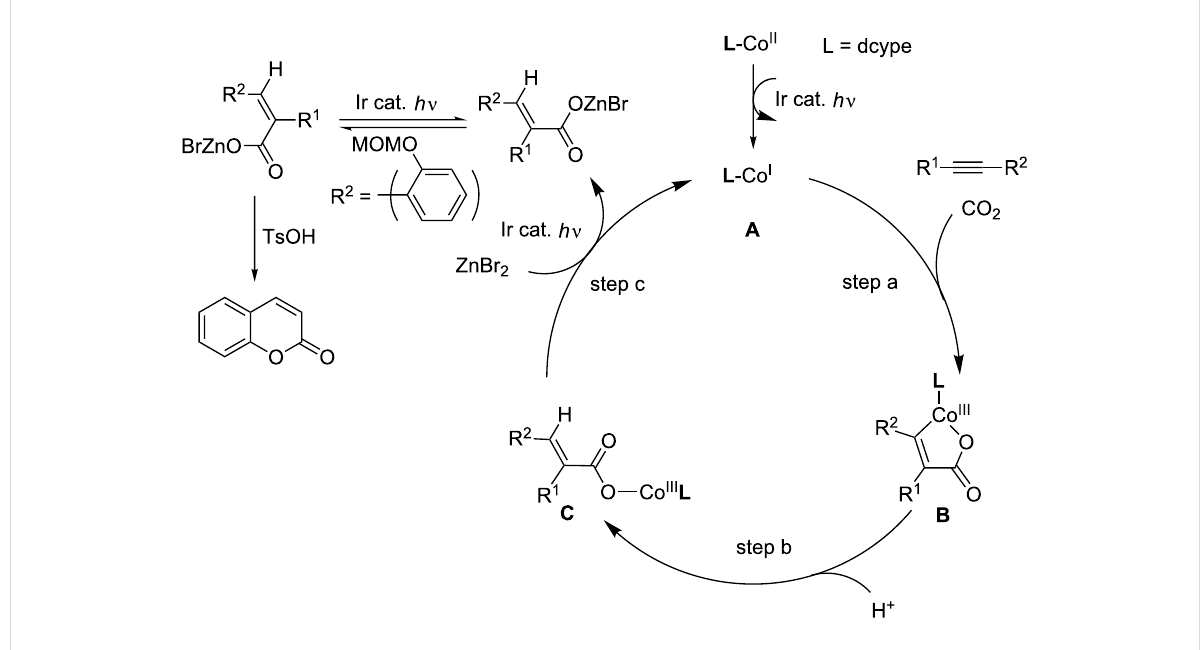
Scheme 23: Proposed reaction mechanism for the Co-catalyzed carboxylative cyclization of ortho -substituted aromatic alkynes.